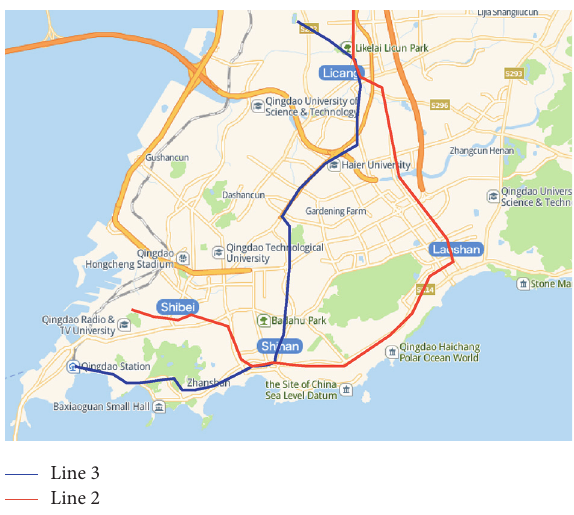
Figure 9: Qingdao metro lines 2 and 3 plane